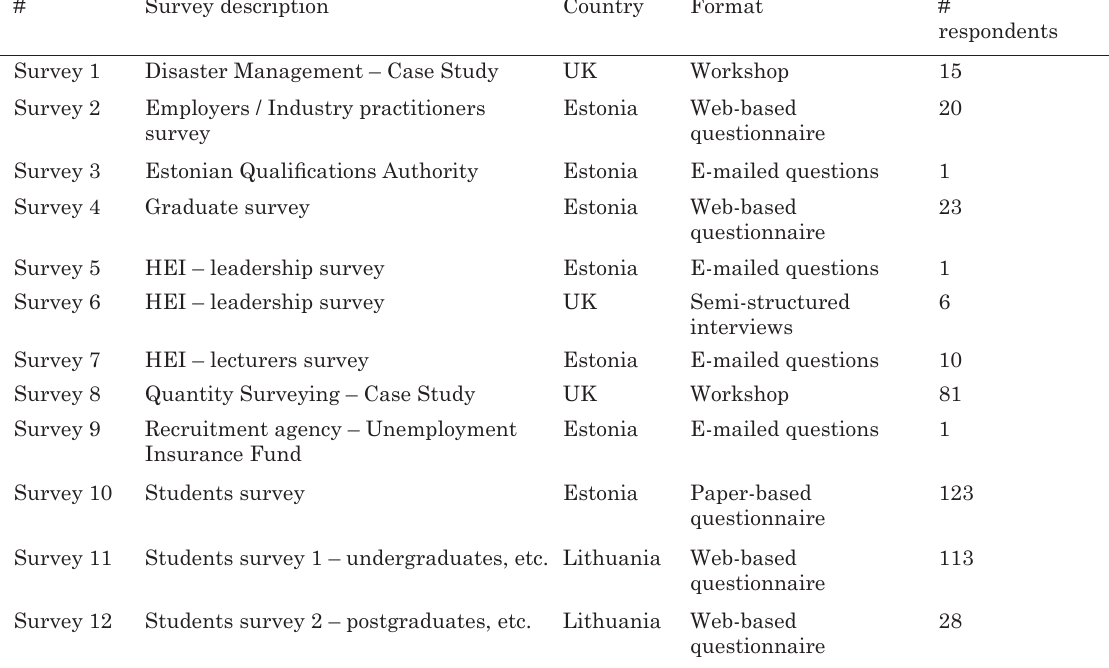
Table 1. Details of the surveys from which selected findings are